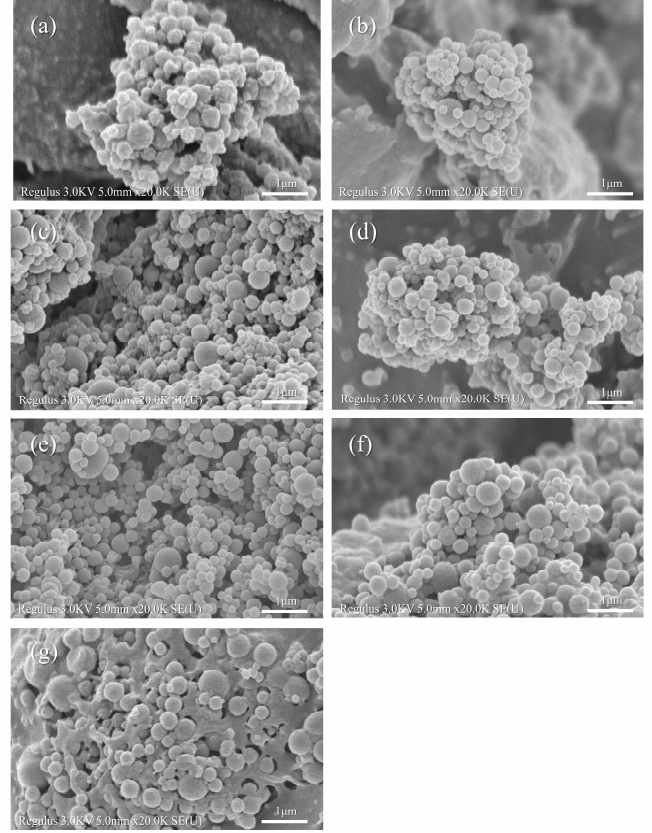
Figure 6. FE–SEM of composite particles: ( a ) zein, ( b ) zein–RT, ( c ) zein–RT–CMS (10:1:10), ( d ) zein– RT–CMS (10:1:20), ( e ) zein–RT–CMS (10:1:30), ( f ) zein–RT–CMS (10:1:40), and ( g ) zein–RT–CMS (10:1:50).